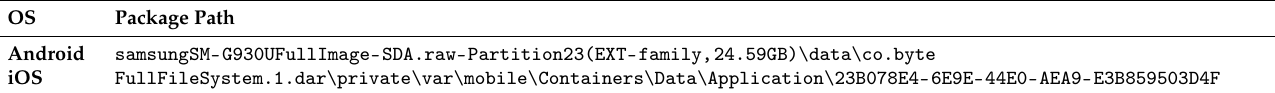
Table 3. Byte app package paths.